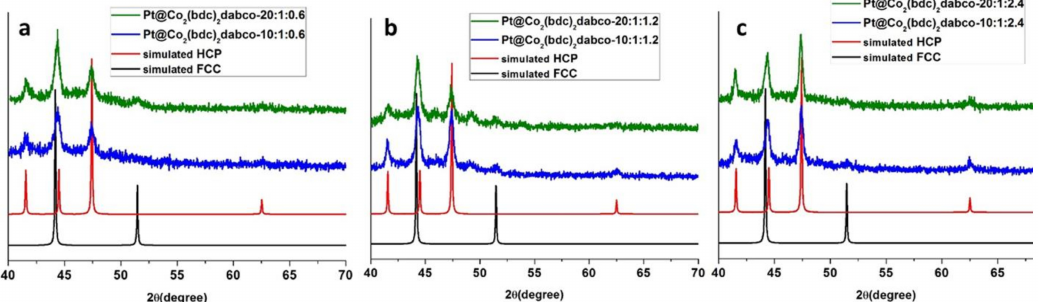
Figure 7. PXRD data showing the change in cobalt structure under various concentrations ( a ) 0.6, ( b ) 1.2, and ( c ) 2.4 molar ratio of NaBH 4 conditions carbonized metal-organic frameworks (MOF).